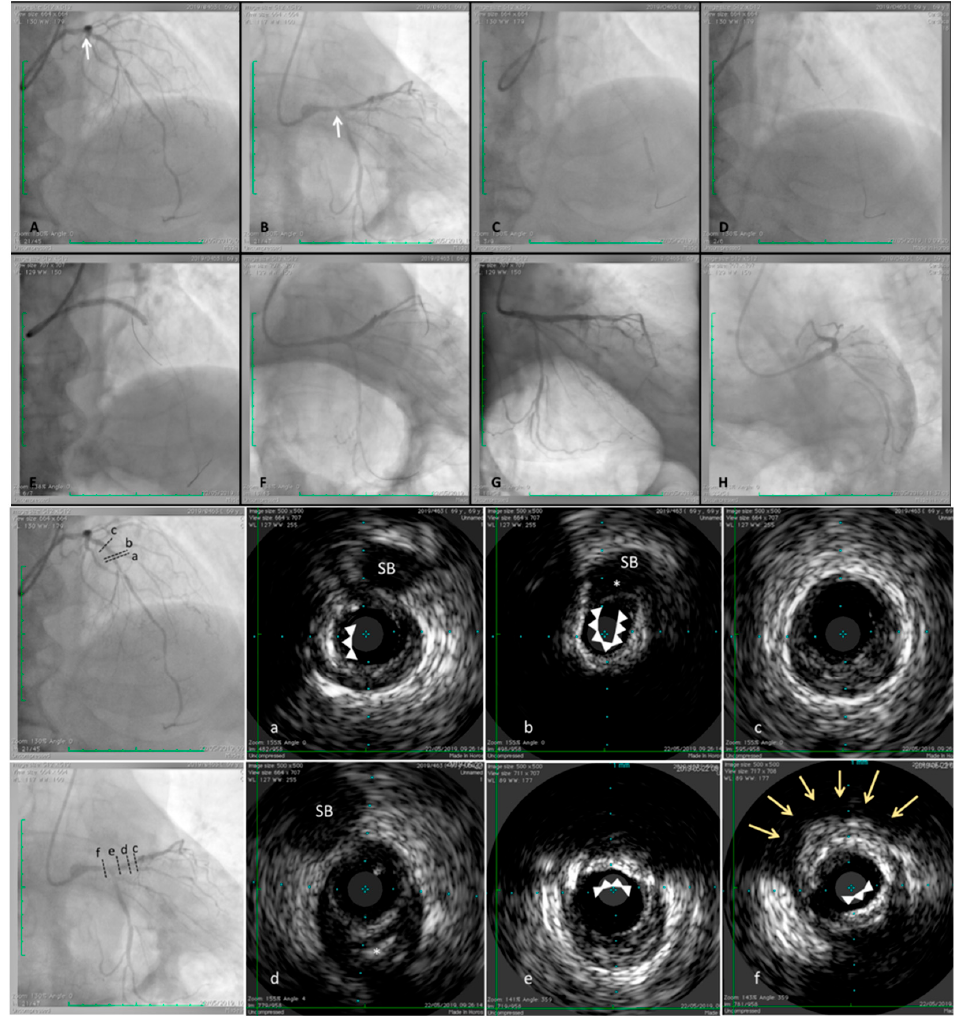
Figure 3. Angiographic assessment by IVUS images in a fibro-calcific plaque involving left anterior descending (LAD) and left main (LM) coronary arteries. 69-year-old male patient, hypertensive, obese, previously treated by percutaneous coronary intervention (PCI) and drug eluting stent (DES) implantation to right coronary artery (RCA) because of inferior STEMI occurred. A staged procedure was scheduled to treat distal and mid left anterior descending (LAD) and to perform an IVUS assessment at proximal LAD and left main LM trunk. After stenting distal and mid segment ( C and D ), followed by a properly post-dilation, IVUS pullback was performed. The images showed a severe and calcific stenosis involving diagonal ostium (cross section “ a ” and “ b ”), an almost complete calcific ring (cross section “ a ” and “ b ”, white arrows) is stopped just at side branch take-off (cross section “ b ”, white asterisk). Proximally, a fibrotic prevalent plaque was detectable (cross section “ c ”). More proximally, fibrotic plaque associated by calcific spot was identified (cross section “ d ”, white asterisk). Immediately distal the bifurcation side (LM–LAD–LCx) another calcific deposits, forming an arch (around 110°), was detected (cross section “ e ”) and the site of distal LM truck a superficial calcific deposit (cross section “ e ”, white arrows) and a deep calcium nodule were detected (cross section “ f ”, yellow arrows), even visible by angiography ( A and B , white arrows). After adequate pre-dilation, a long stent was implanted to LM-LAD ( E ) and a satisfactory result was reached ( F , G , H ).